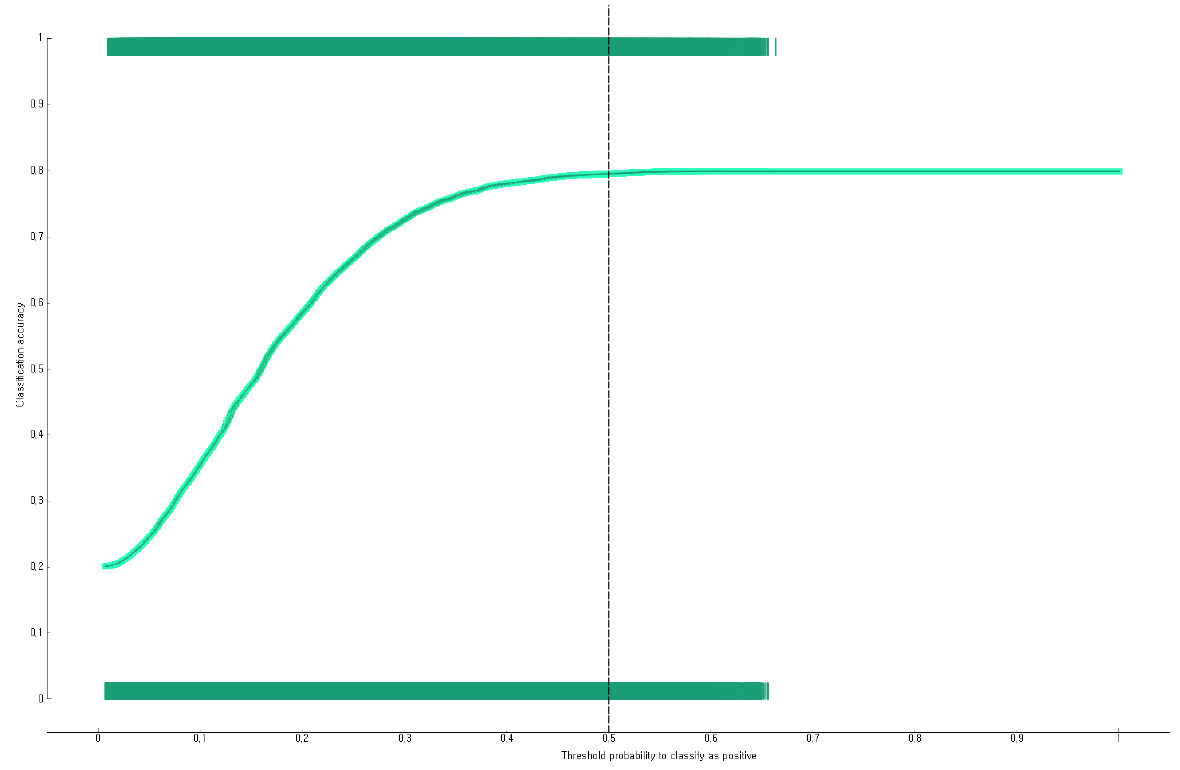
Figure 3. General accuracy (10-fold validation) of Bayesian nomogram for predicting the subjective life dissatisfaction of Korean adults in COVID-19 pandemic in Korea.